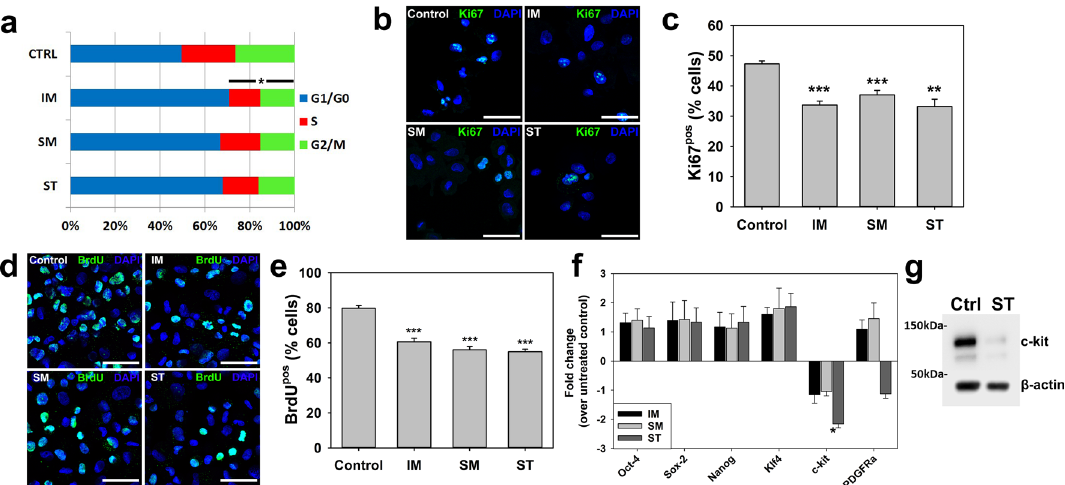
Figure 2. CPC population maintenance reduced by RTKIs. ( a ) CPC cell cycle activity was reduced by RTKIs: 10 µM IM, 1.25 µM SM or 10 µM ST for 24 h reduced cells in S, G2 and M phases (n = 3). ( b ) Representative Ki67 ICC images (scale bar = 50 µm). ( c ) Ki67 protein expression reduced relative to control CPCs by 10 µM IM, 1.25 µM SM or 10 µM ST (n = 3). ( d ) Representative BrdU ICC images (scale bar = 50 µm). ( e ) CPC proliferation reduced by RTKIs: percentage BrdU pos CPCs reduced by 10 µM IM, 1.25 µM SM or 10 µM ST over 48 h (n = 3). ( f ) Real-time qPCR analysis of CPC ‘stemness’ and CPC marker gene expression: reduction in c-kit expression by 5 µM ST after 7 days (n = 3). ( g ) Downregulation of c-kit protein expression by 5 µM ST after 7 days. All data are mean ± SEM; significance was determined by ANOVA with Holm-Šídák post hoc test to identify differences (** p < 0.01; *** p < 0.001). Blots cropped to relevant data, with optical density normalized to the loading control protein; full blot images presented in Supplementary Fig.